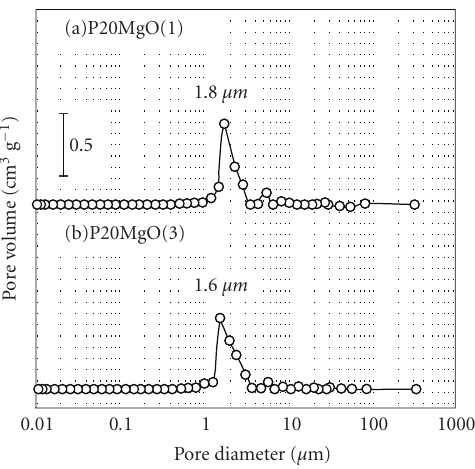
Figure 5: Pore size distributions of (a) P20MgO(1) and (b)